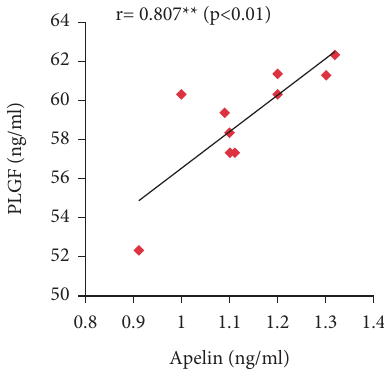
Figure 10: Correlation between serum apelin and PLGF in the PE group.